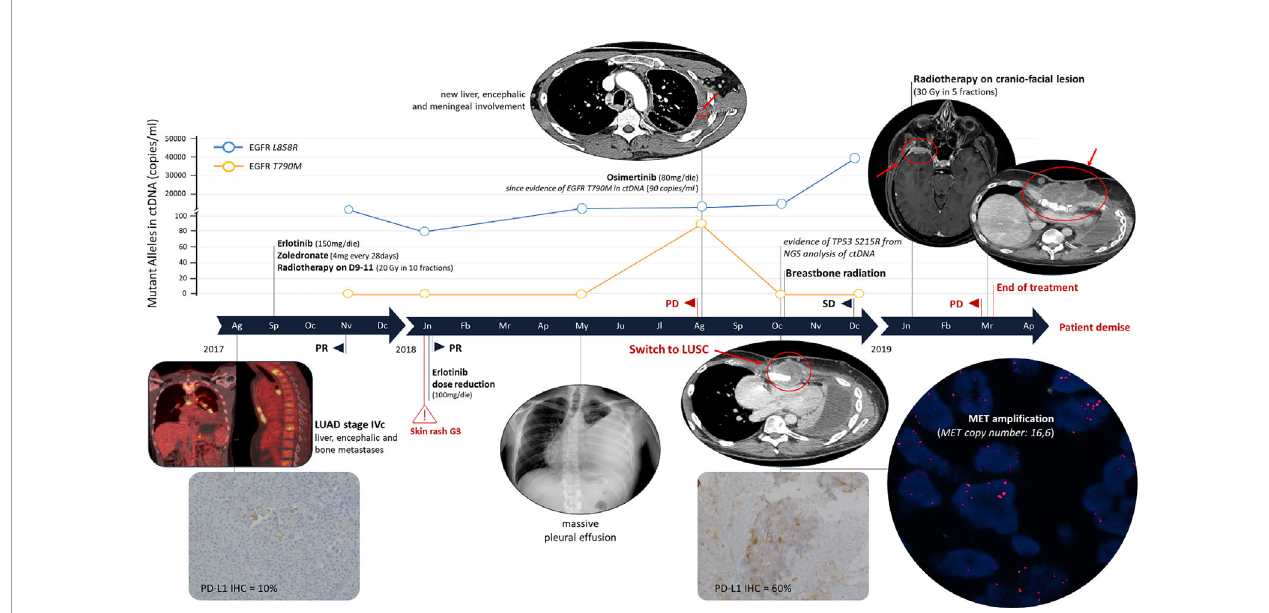
FIGURE 2 | Clinical Timeline. The immunohistochemistry evaluation of PD-L1 was performed using a monoclonal primary antibody SP263 clone on the Ventana Medical System (Roche). MET ampli fi cation was evaluated by fl uorescence in situ hybridization using the probes: LSI MET spectrum red and CEP7 spectrum green (Vysis – Abbott). PR, partial response; SD, stable disease; PD, progression disease; NGS, Next Generation Sequencing; LUAD, lung adenocarcinoma; LUSC, lung squamous-cell